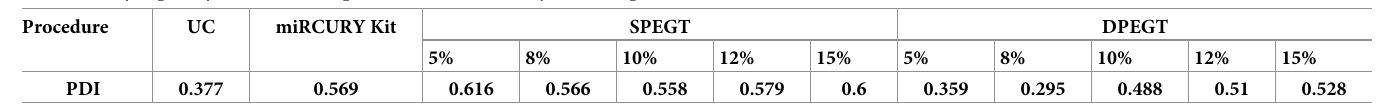
Table 1. Polydispersity index (PDI) of plasma sEVs enriched by different